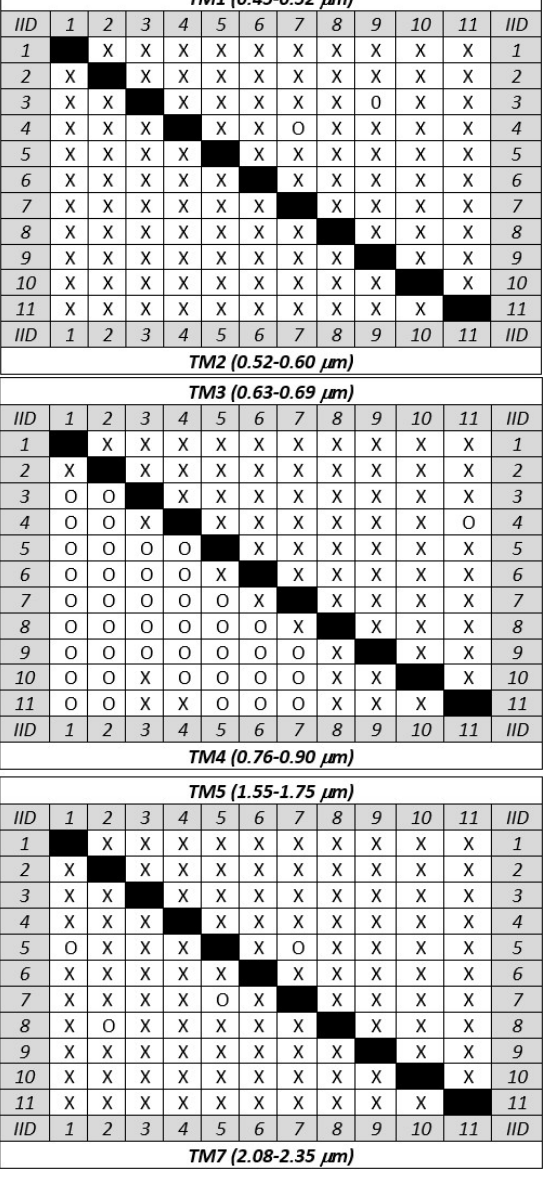
Figure 3. Connectivity matrices for different spectral bands of ‘Multan’ dataset (see Section 3). In the upper and lower triangles of each matrix, a single spectral band is represented. The content of the cell at the intersection of two image identifiers (IIDs) shows the presence of sufficient (‘X’) or insufficient (‘O’) TPs between those images.